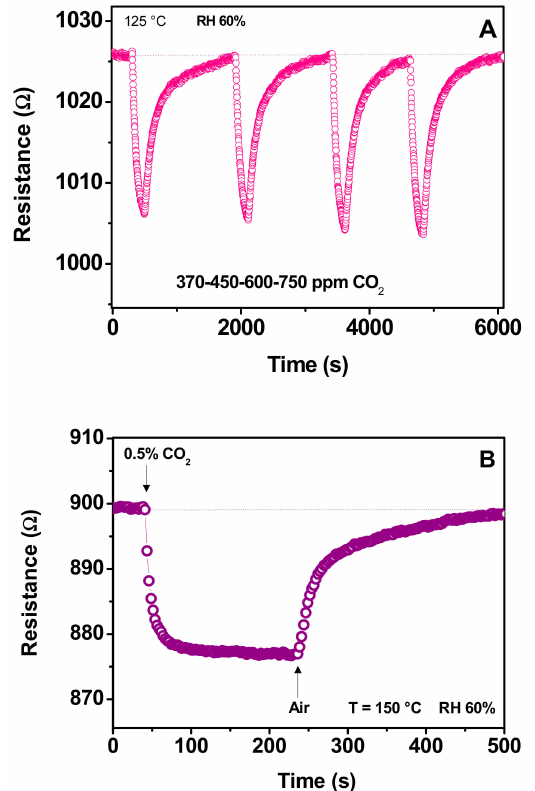
Figure 11. Transient response of the sensor to pulses of CO 2 at the working temperature of ( A ) 125 ◦ C and ( B ) 150 ◦